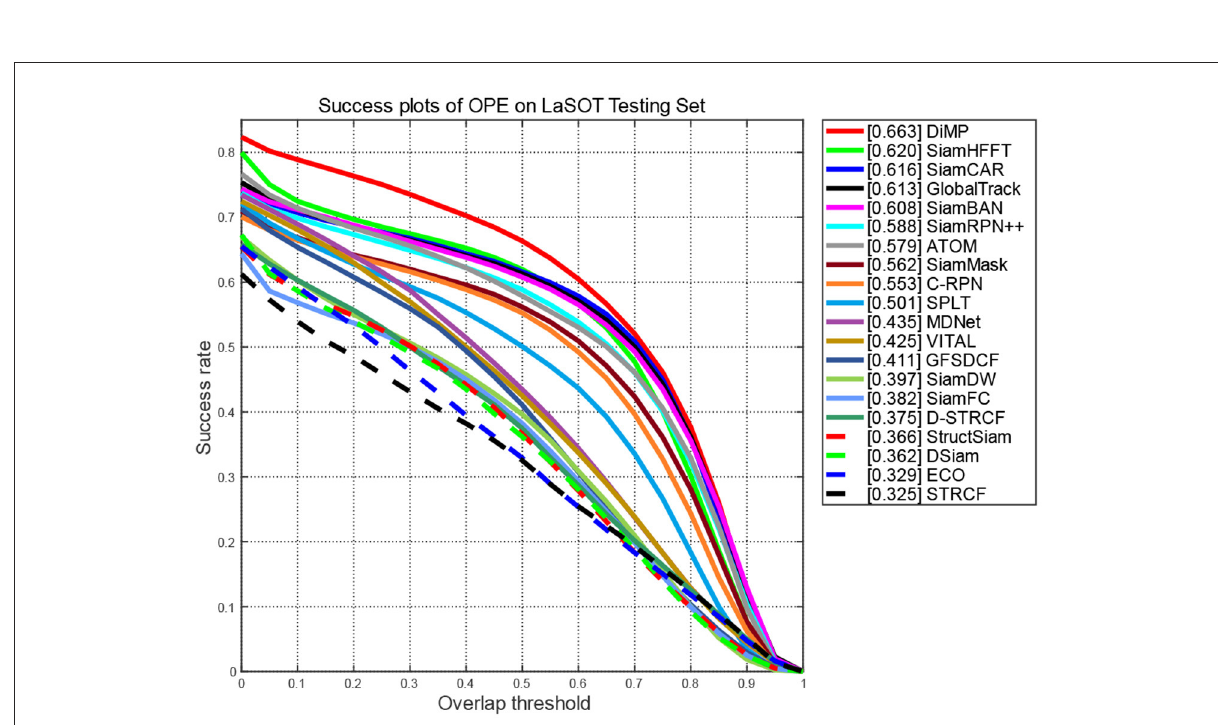
FIGURE5 Success scores of compared trackers on